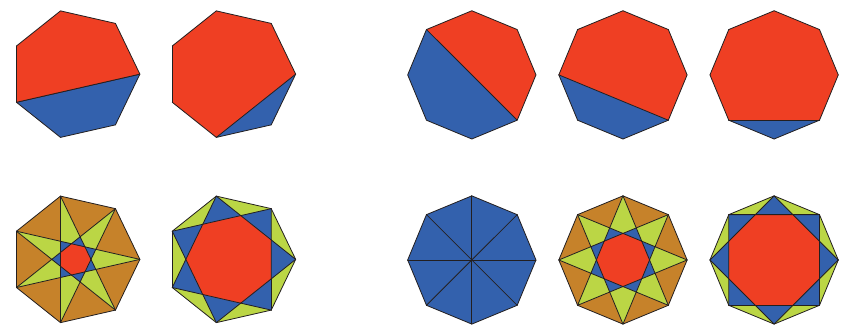
Figure 28. Cutting heptagons and octagons with diagonal knives.